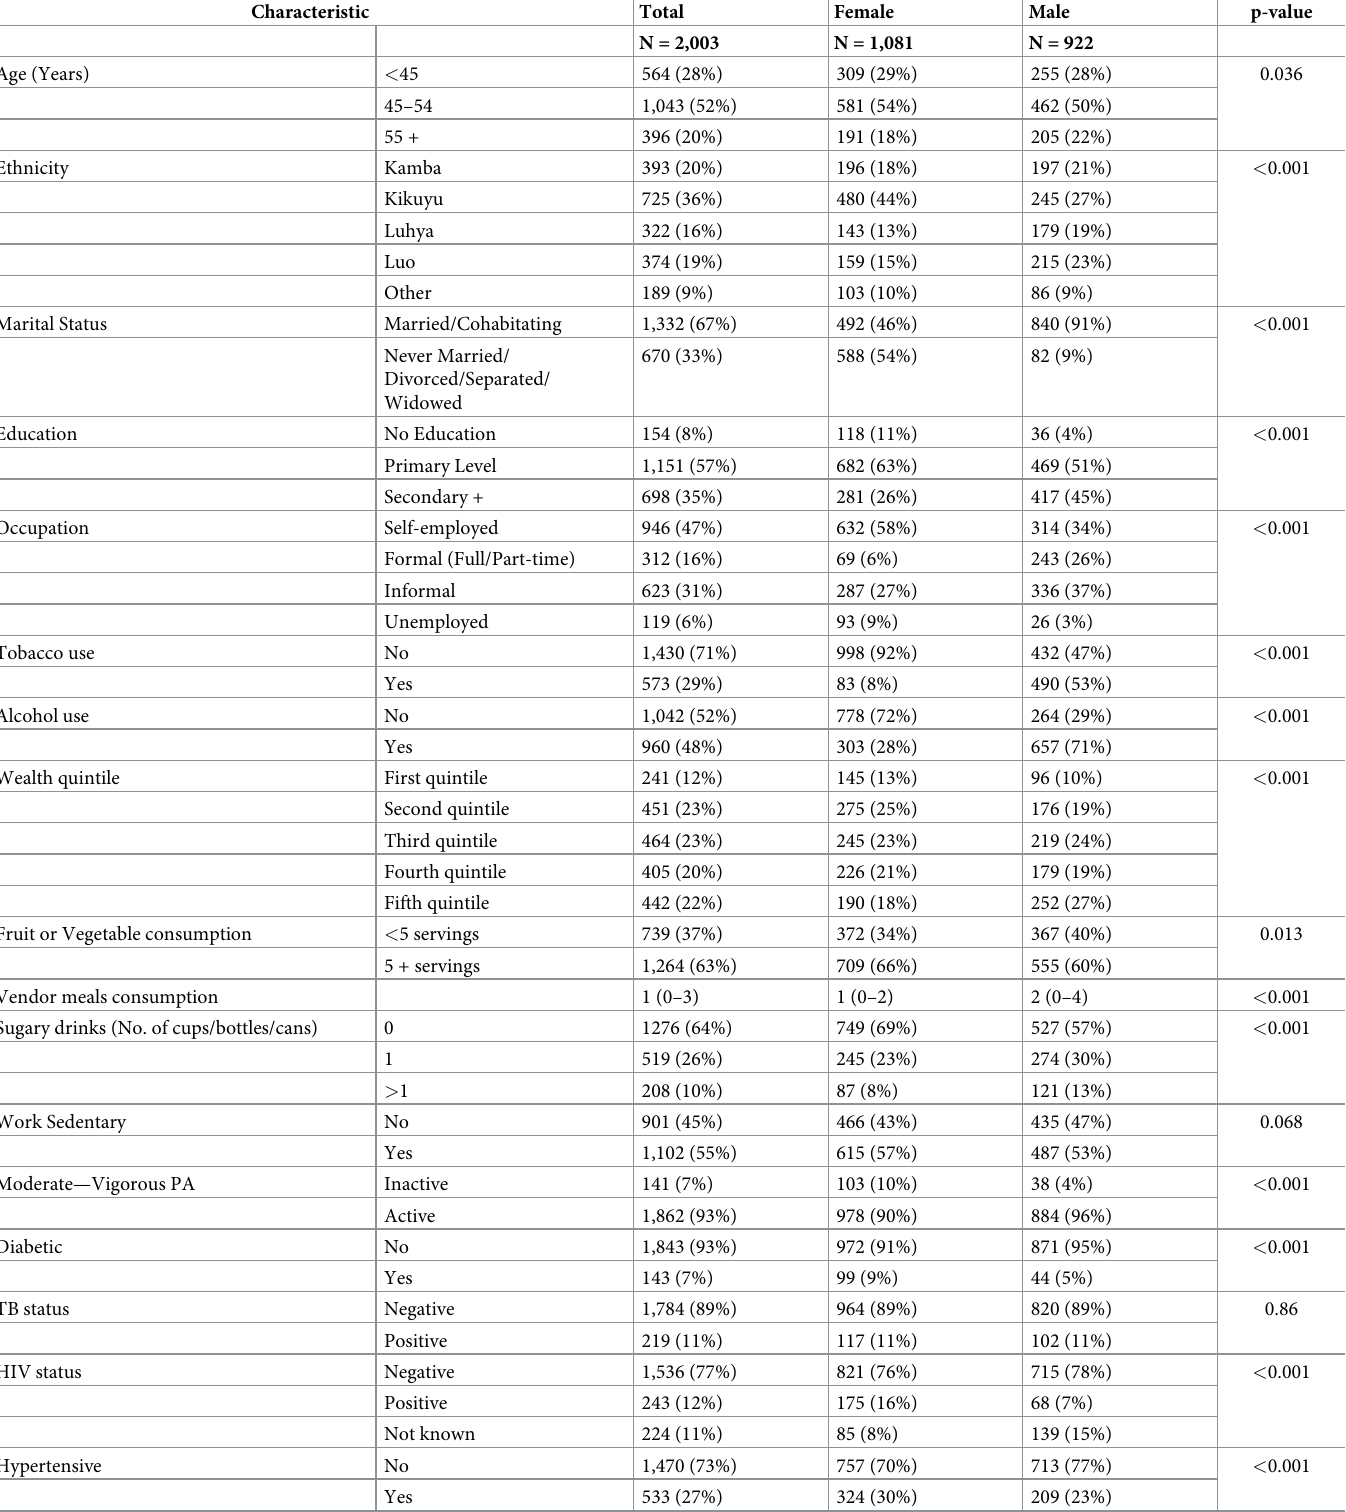
Table 2. Sociodemographic, behavioral and clinical/biological characteristic of